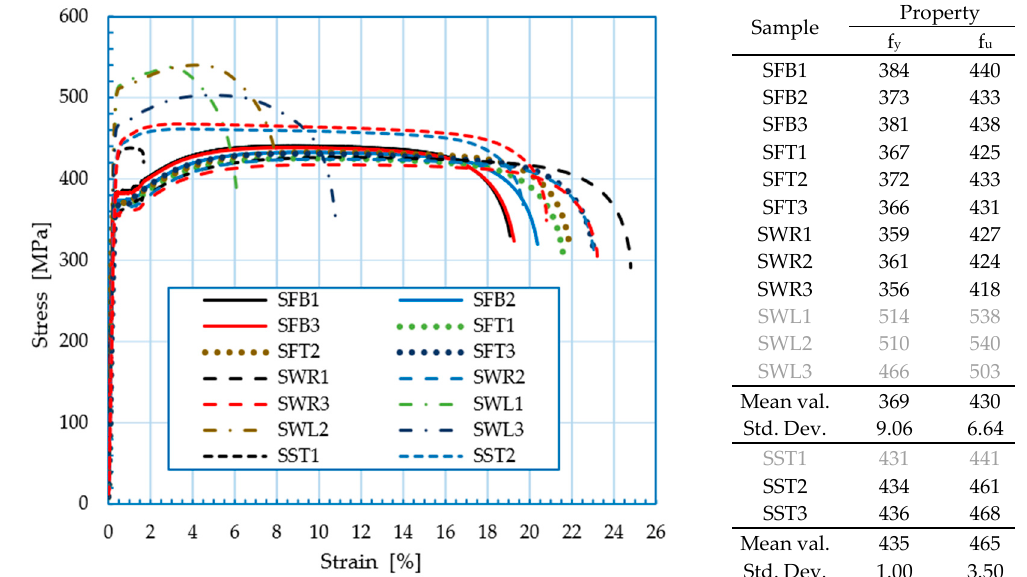
Figure 4. Stress-strain curves with main mechanical properties of tested coupons (RHS 180 × 80 × 3 and RHS 30 × 20 × 2).